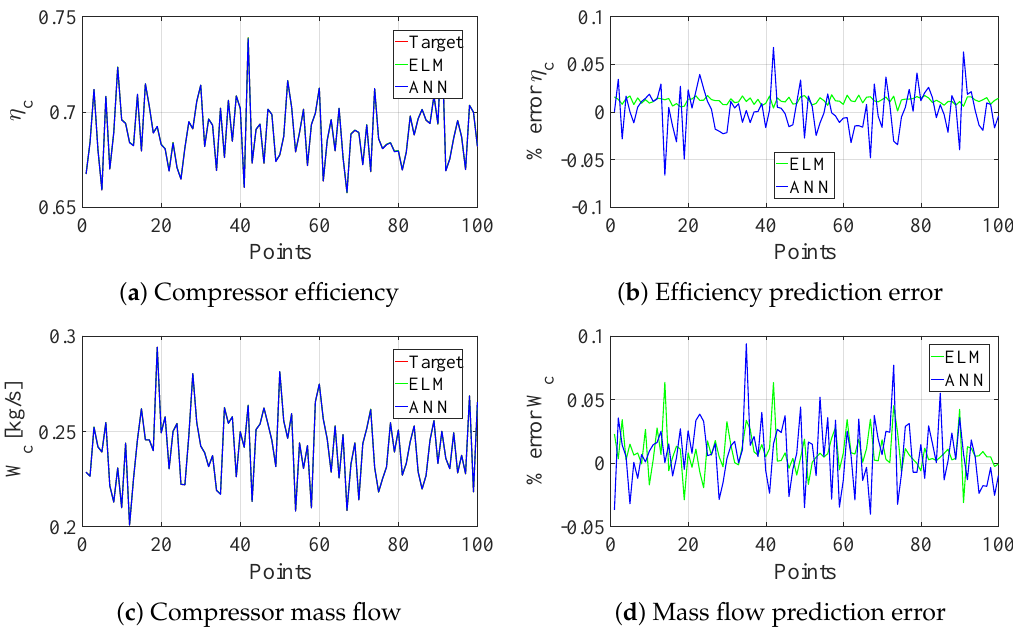
Figure 12. Compressor degradation in flight regime 3 with input vector 2: comparison between the target and prediction of the component performance parameters.